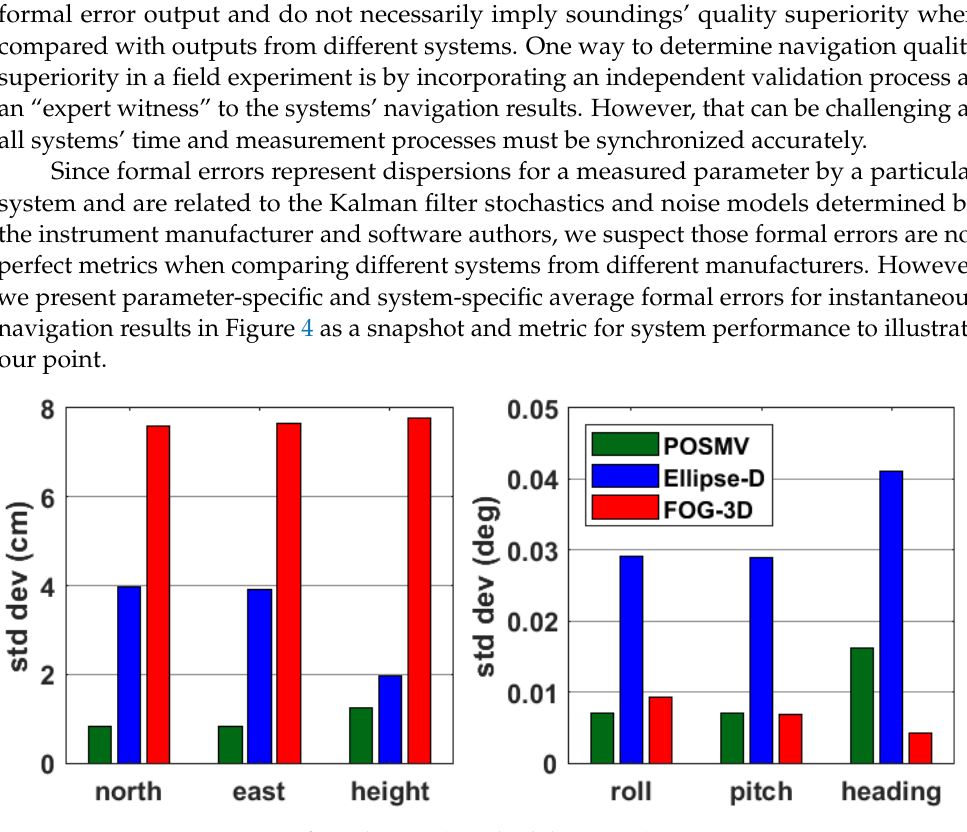
Figure 4. GNSS + INS average formal errors (standard deviations).